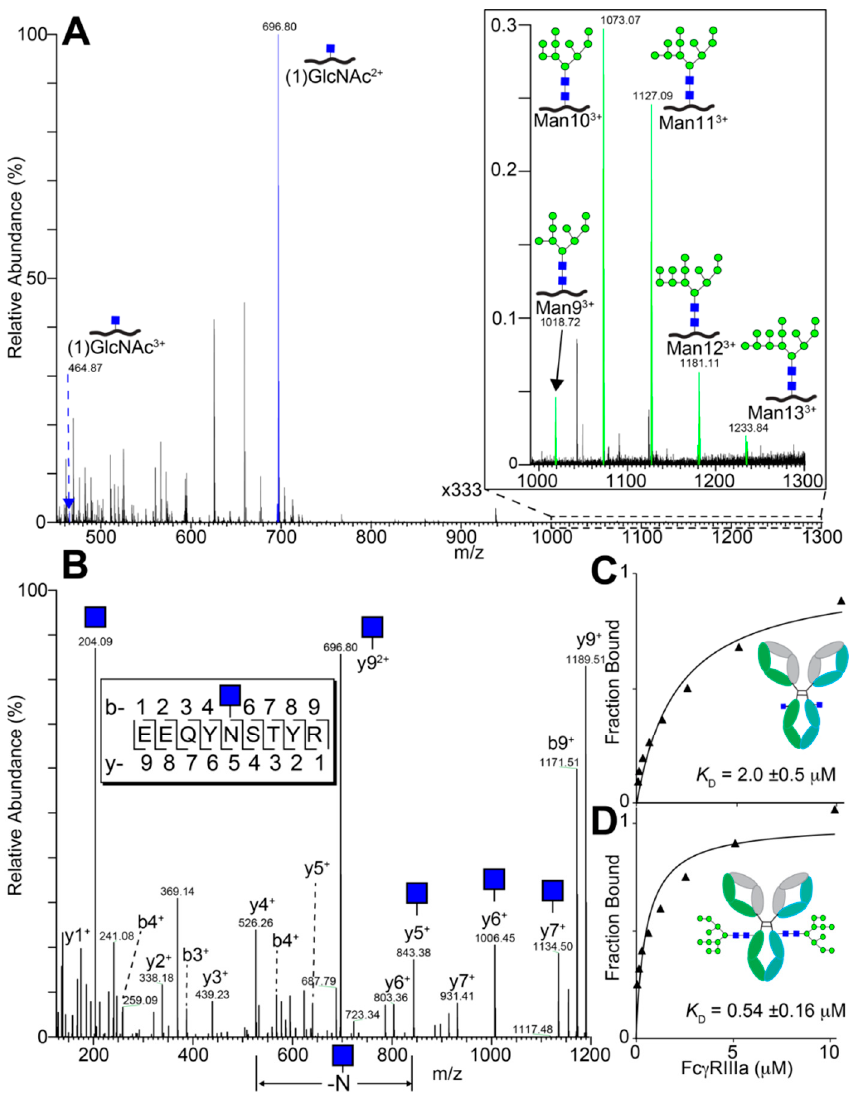
Figure 6. Yeast-expressed Rituximab composition and receptor binding. ( A ) Total ion current from ESI-MS spectra of trypsinized Rituximab expressed from the EBY100-(GPD) EndoS2 strain summed from 11–15 min; doubly charged ions corresponding to oligomannose N -glycoforms were not observed. Isobaric ions were not distinguished, thus each cartoon represents multiple possible configurations. ( B ) ESI-MS/MS of the (1) GlcNAc glycopeptide from panel A showing a single GlcNAc residue at N297. Rituximab displaying either truncated ( C ) or yeast N -glycans ( D ) binding to high affinity Fc γ RIIIa (V158) variant as determined by surface plasmon